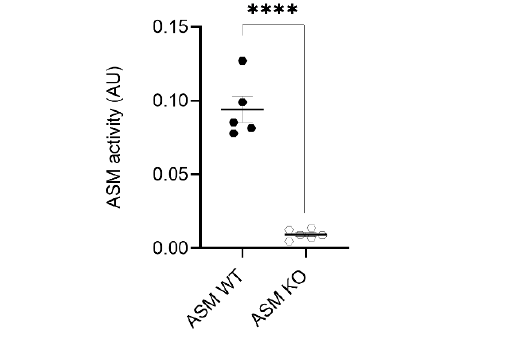
Figure 1. Acid sphingomyelinase (ASM) activity is decreased in cortices of ASM KO mice. ASM activity was measured in triplicates using an enzymatic activity assay. Bars indicate mean ± SEM; n = 5–6 animals; **** p ≤ 0.0001.